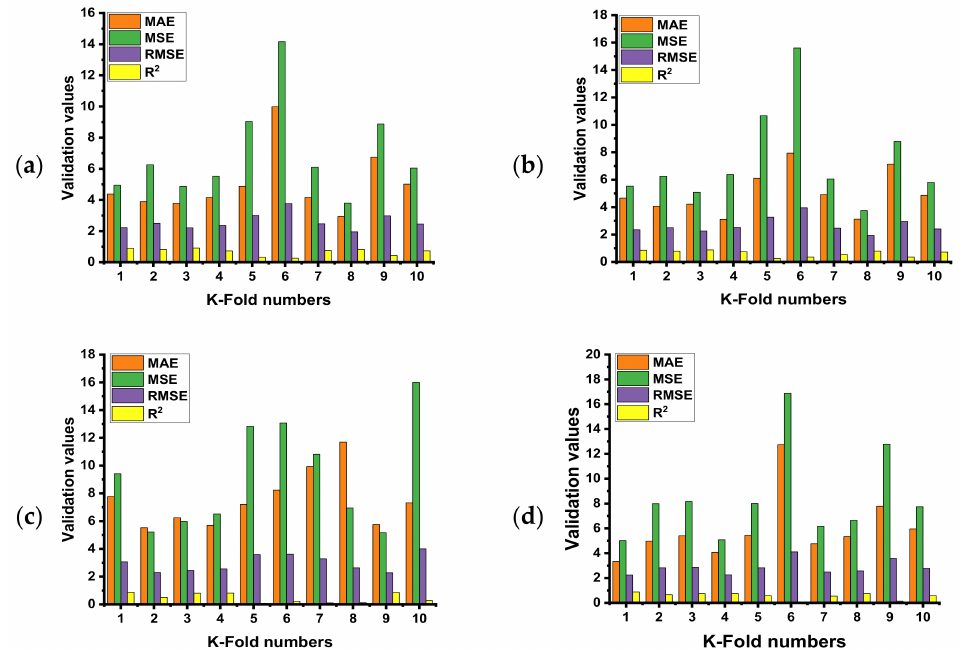
Figure 15. Statistical indicators of k-fold CV for the employed models; ( a ) RF model, ( b ) BR model, ( c ) MLP model, and ( d ) DT model.